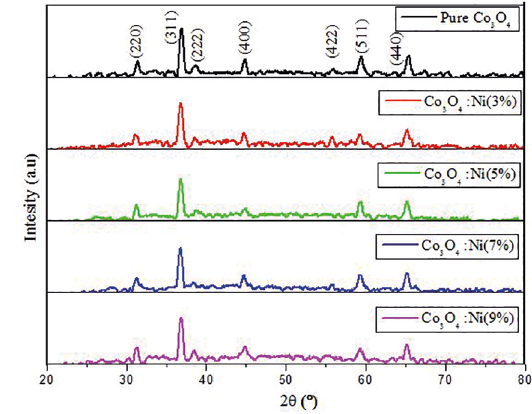
O powders for 3 4